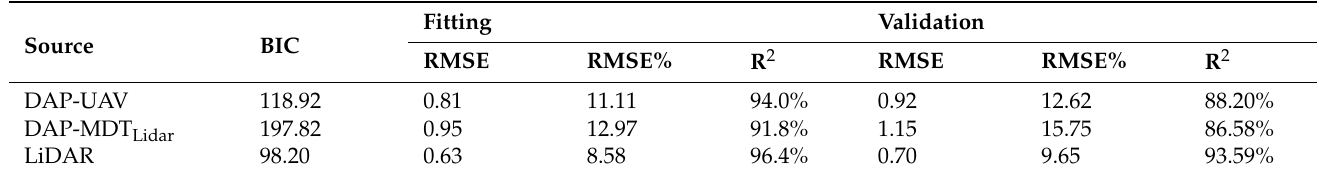
Table 9. Statistics from the fitting and validation of the best models for estimating average height (DAP-UAV, DAP-DTM LiDAR , and LiDAR).